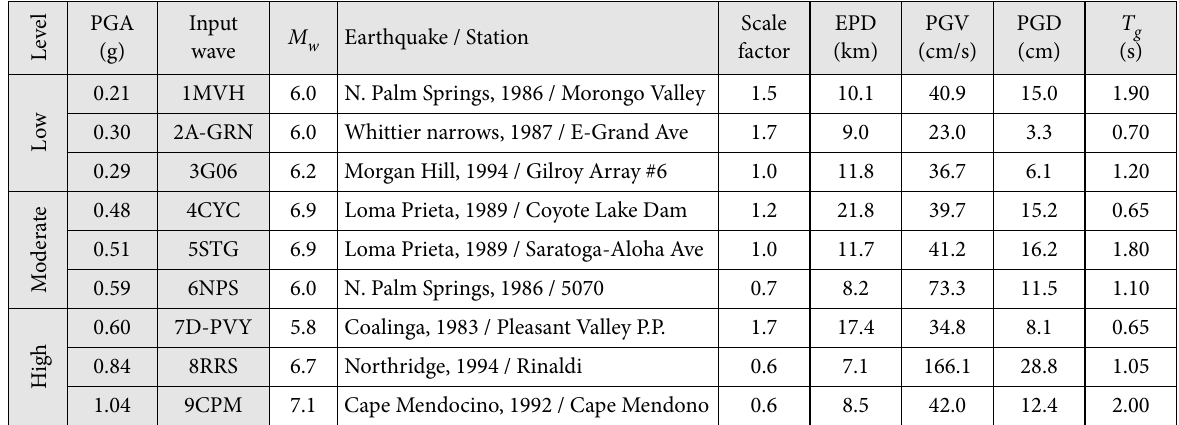
Table 2. Characteristics of earthquake ground motion recordsused in the